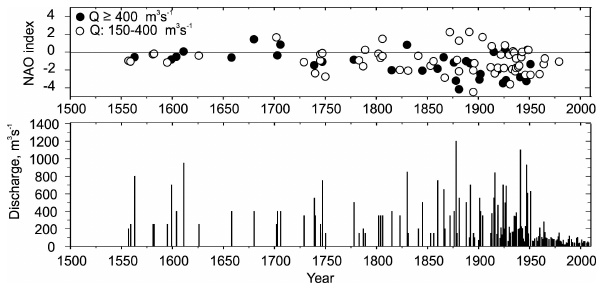
Figure 3. Reconstructed flood record in Aranjuez during the histor- ical period (1557–1912) and annual maximum flood series during the instrumental periods (1913–2008), with vertical bars showing the peak discharge. NAO index values associated with flood dates are indicated (historical NAO index after Luterbacher et al., 1999,